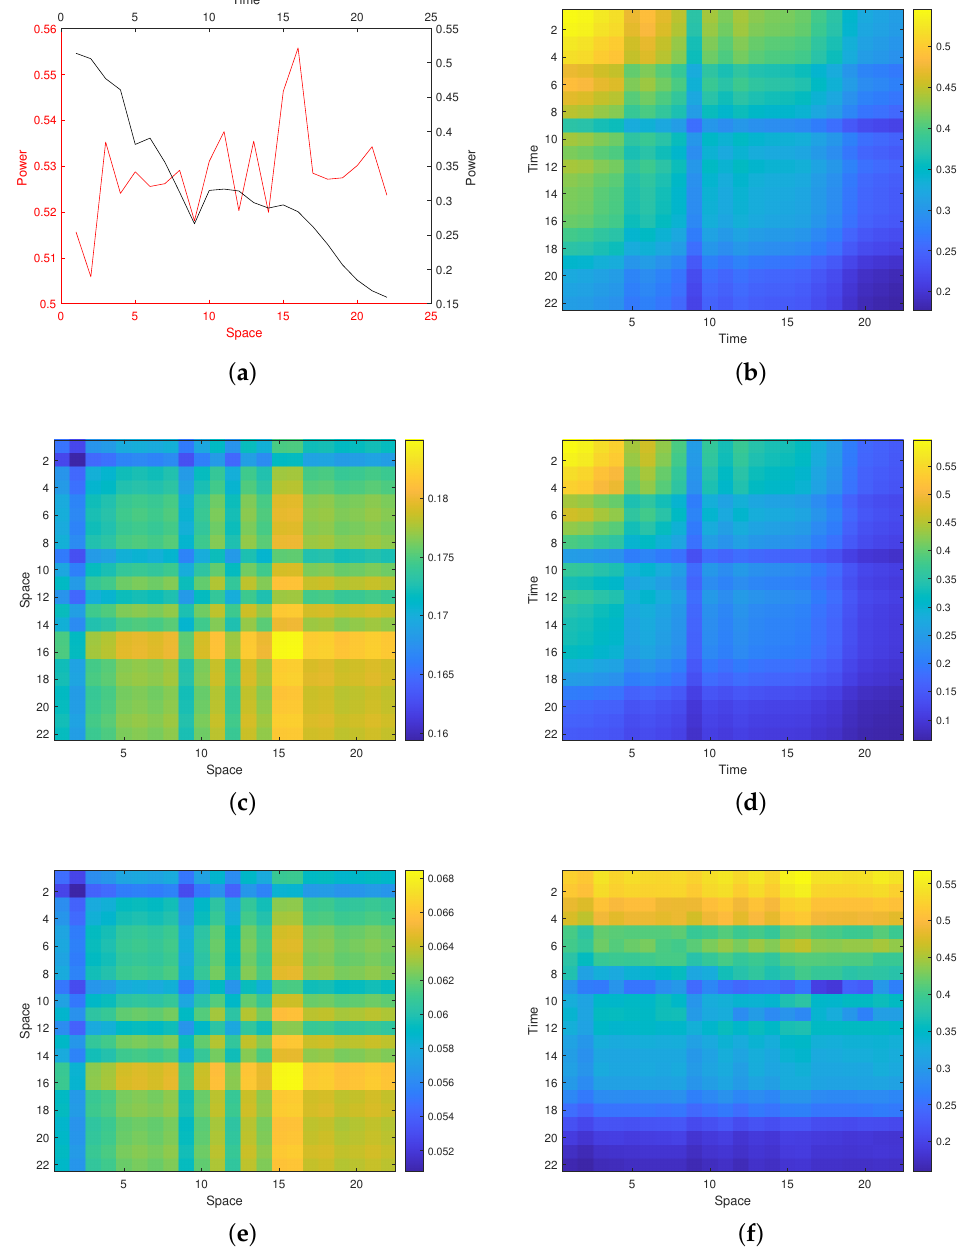
Figure 2. Time series-to-spatial–temporal image matrix conversion: ( a ) variation of power over space (red color) and time (black color); ( b ) time domain image matrix derived from Equation (1); ( c ) spacial domain image matrix derived from Equation (1); ( d ) time domain GCF image; ( e ) space domain GCF image; ( f ) time–space domain GCF